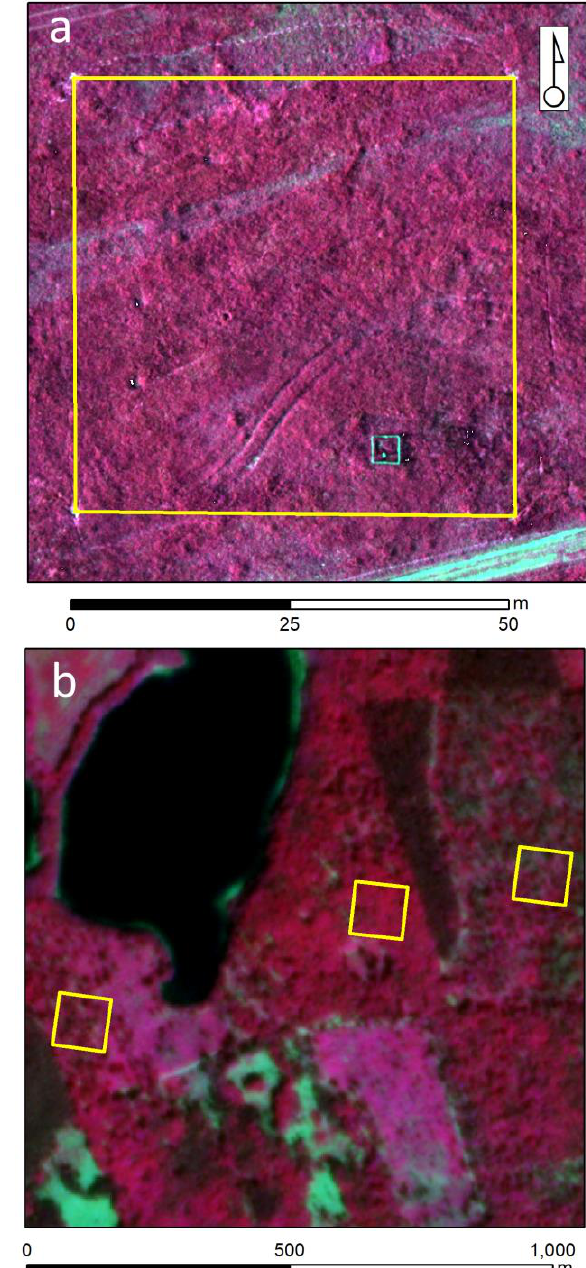
Figure 3: a) UAV false color image of a grassland plot, 50x50 m. b) Planet Dove false color image of three forest plots of different types and mixtures of species and age class (100x100